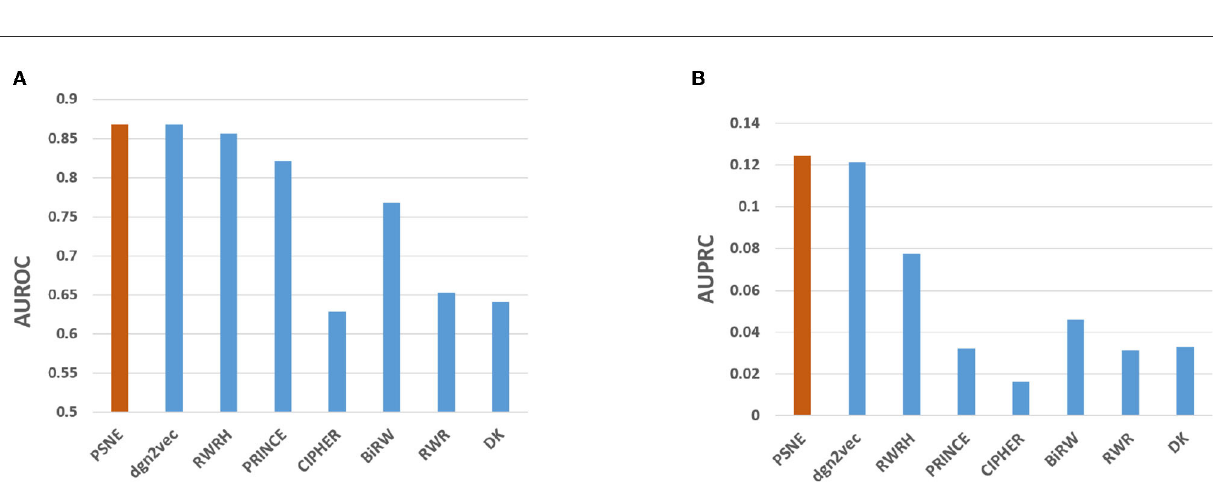
Let G = ( V , E , W ) denote a heterogeneous network. Let f